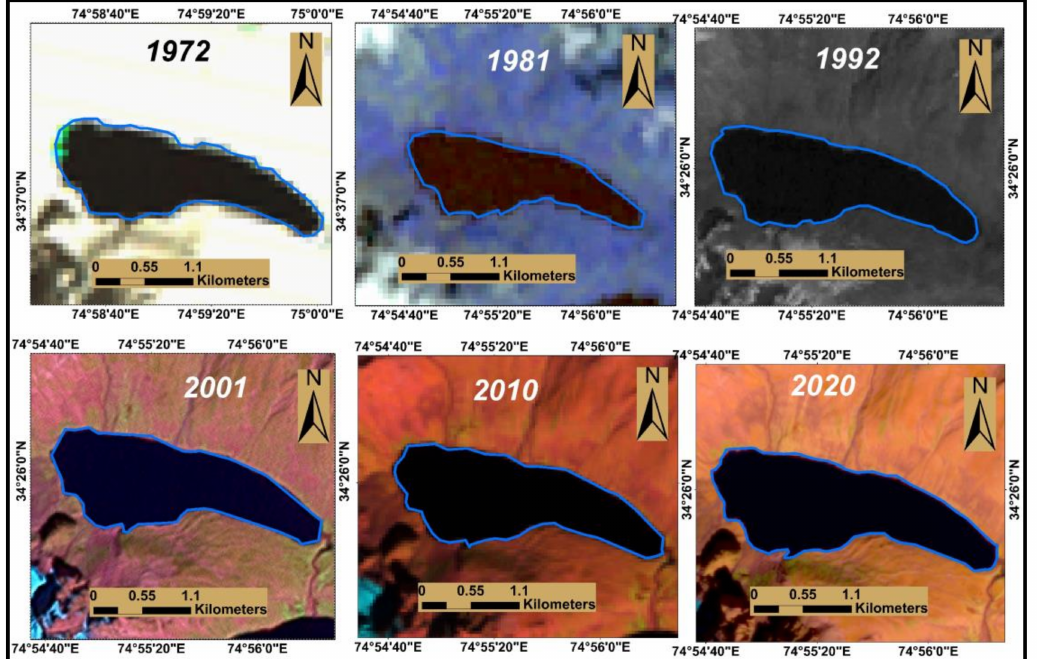
Figure 7. Gangabal lake expansion from 1972 to